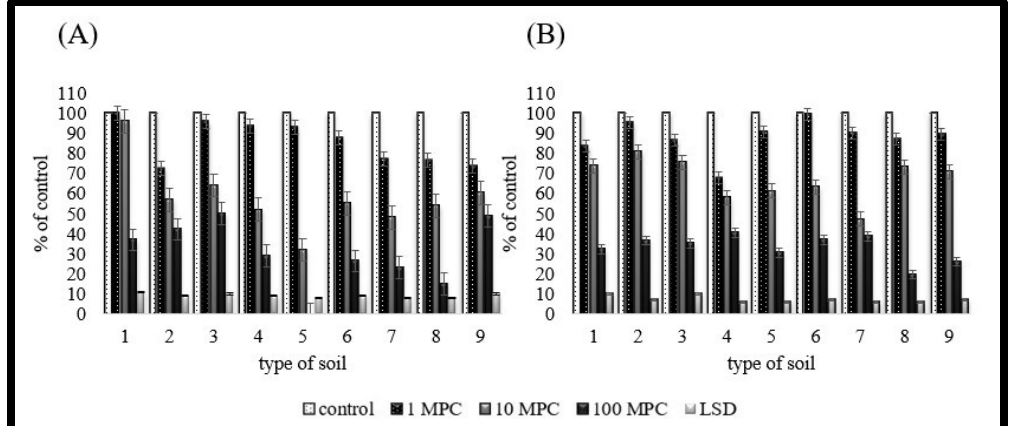
Figure 2. Change in Azotobacter sp. abundance ( A ) and total number of bacteria ( B ) in forest soils: 1, brown leached soil; 2, brown typical soil; 3, brown carbonate soil; 4, yellow soil; 5, acid brown forest soil; 6, sod-carbonate typical soil; 7, leached sod-carbonate soil; 8, acid brown forest podzolized soil; and 9, brown forest soils slightly unsaturated.